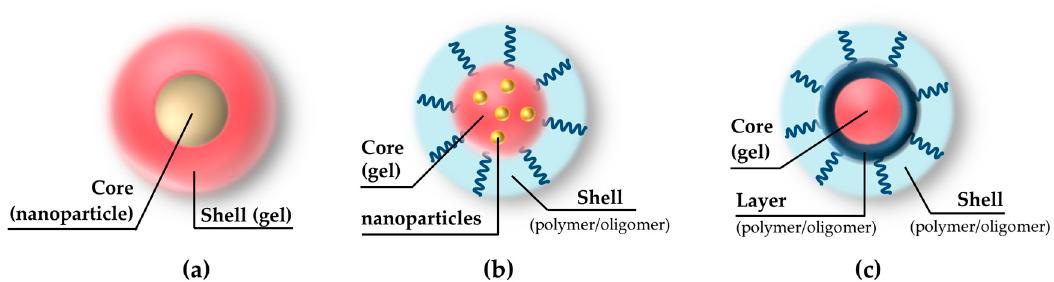
Figure 1. Common hybrid nanogels morphologies: ( a ) Nanoparticle as the core, encapsulated by the nanogel shell; ( b ) core-shell with nanoparticle homogeneously located in the nanogel core and surrounded by a polymeric shell; and ( c ) polymer network assembled in core-layer-shell structure. (Artwork not drawn to scale, the sizes for nanoparticles or nanogels range from 50 to 400 nm).